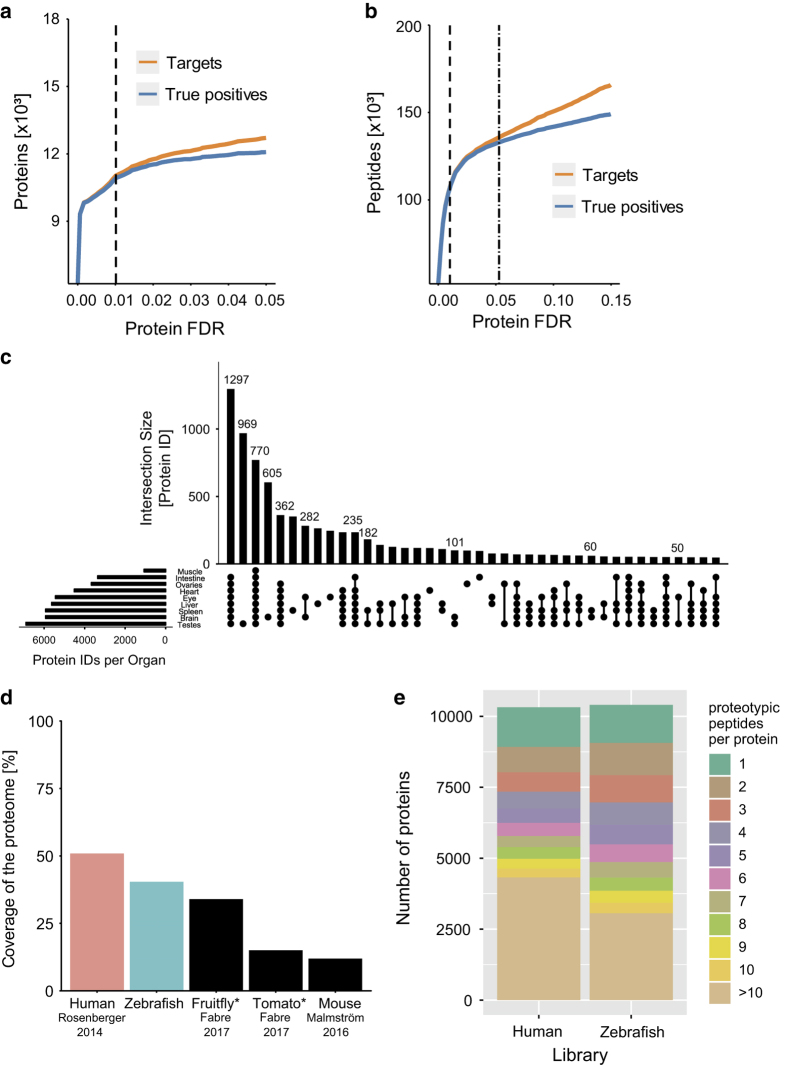
Characteristics of the zebrafish SWATH spectral library.(a) Number of true positive (blue) and target (orange) protein identifications at a given protein FDR. The applied MAYU protein-FDR cutoff is shown with a vertical dashed line. (b) Number of true positive (blue) and target (orange) peptide identifications at a given protein FDR. The applied MAYU protein FDR-cutoff of 0.01 is shown with a vertical dashed line. The dotted-dashed line indicates the peptide FDR threshold (0.01) that was applied to all peptides of proteins passing the protein cutoff. (c) Contribution of the individual organs to the number of identified proteins by proteotypic peptides. (d) Coverage of the proteome for SWATH spectral libraries of different species17,18,39. The coverage was calculated using the number of protein identifications with proteotypic peptides against the total number of proteins present in the sequence database, or the numbers from the cited publication were used (marked with an asterisk). (e) Barplot of the proteotypic peptides per protein in the human17 and the zebrafish library.